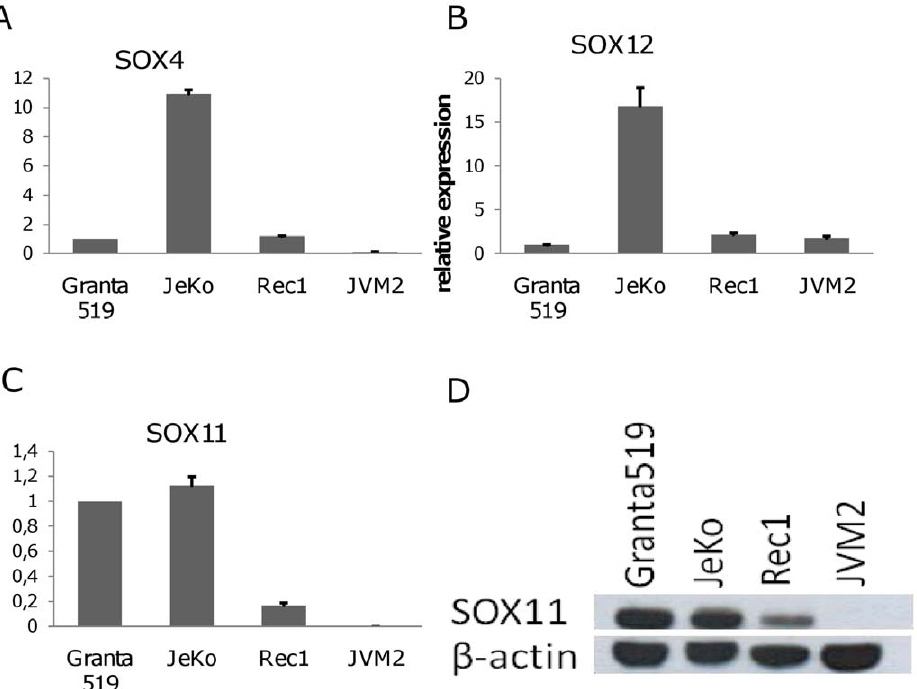
Figure 1. Expression of SOXC genes in MCL cell lines. Expression of SOX4 (A), SOX12 (B) and SOX11 (C) in the MCL cell lines Granta 519, JeKo, Rec1 and JVM2 by quantitative RT- PCR. Granta 519 express high levels of SOX11 mRNA but low levels of the other SOXC genes while no SOX11 mRNA expression was detected in JVM2. (D) WB showed that Granta 519, JeKo and Rec1, but not JVM2, express SOX11 protein.